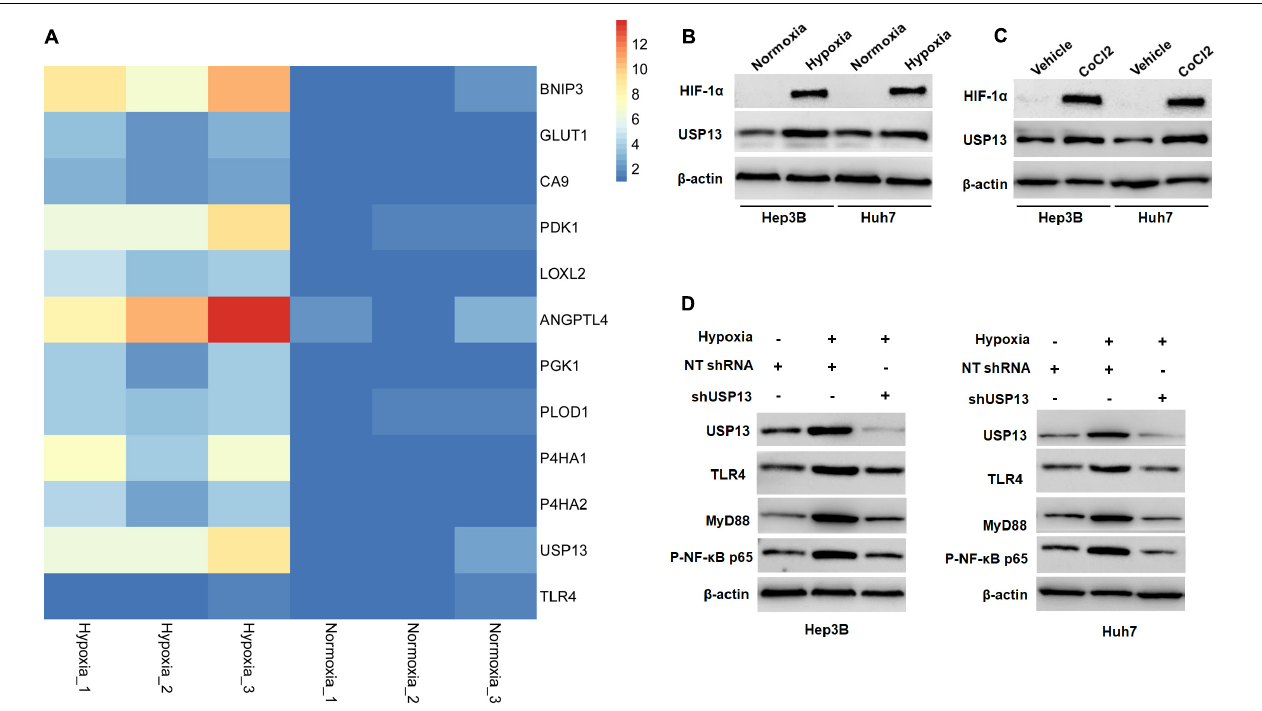
FIGURE 7 | Hypoxia activates the USP13/TLR4/MyD88/NF- κ B pathway in HCC cells. (A) Heatmap of the differentially expressed genes, including USP13, TLR4, and 10 HIF target genes. (B) The levels of HIF-1 α and USP13 protein were increased in Hep3B and Huh7 cells under hypoxia conditions. (C) CoCl 2 treatment (150 µ M) resulted in the increased levels of HIF-1 α and USP13 protein in Hep3B and Huh7 cells. (D) Hypoxia increased USP13, TLR4, MyD88, and P-NF- κ B p65 proteins, which was subsequently reduced by USP13